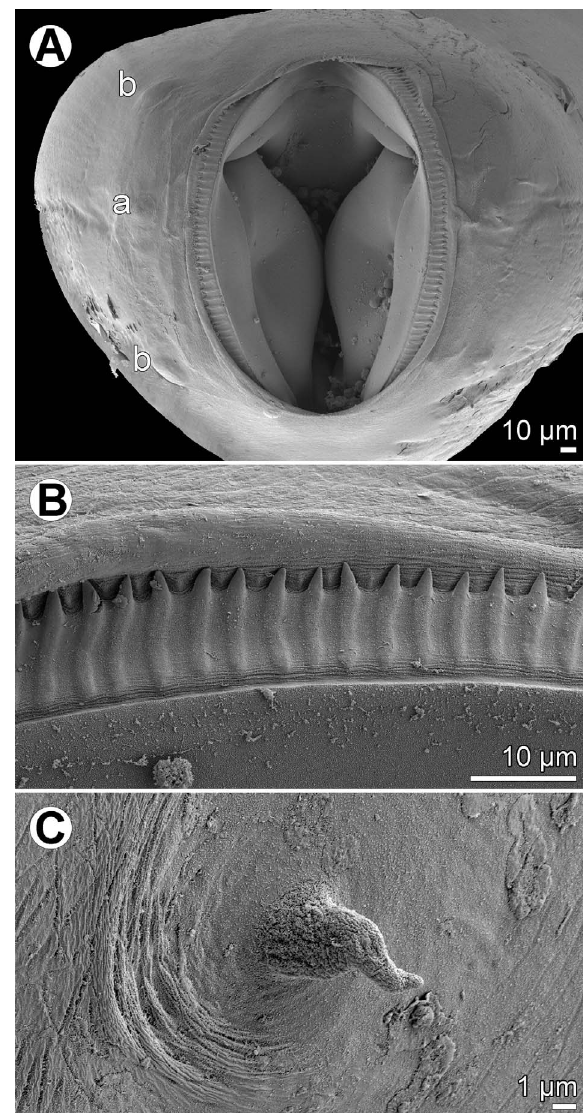
Figure 2. Cucullanus austropacificus n. sp., scanning electron micrographs. (A) Cephalic end, apical view; (B) cephalic teeth; (C) deirid. (a) amphid; (b) cephalic double